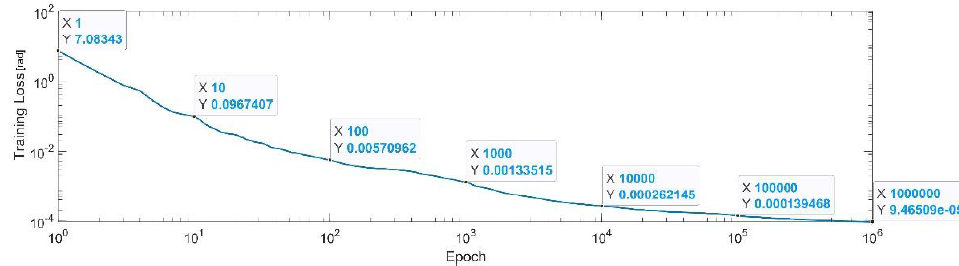
Figure 11. Convergence of the neural network for the first generalized coordinate 𝑞 2 (log scale).